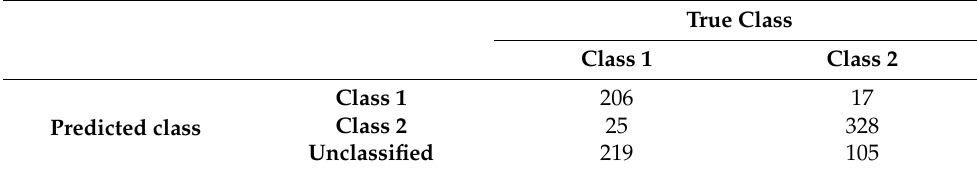
Table 10. Total confusion matrix of 10-fold cross-validation of classification results with the GRS with 810 samples of training data using attributes 4, 6, and 7 of the Raisin dataset.